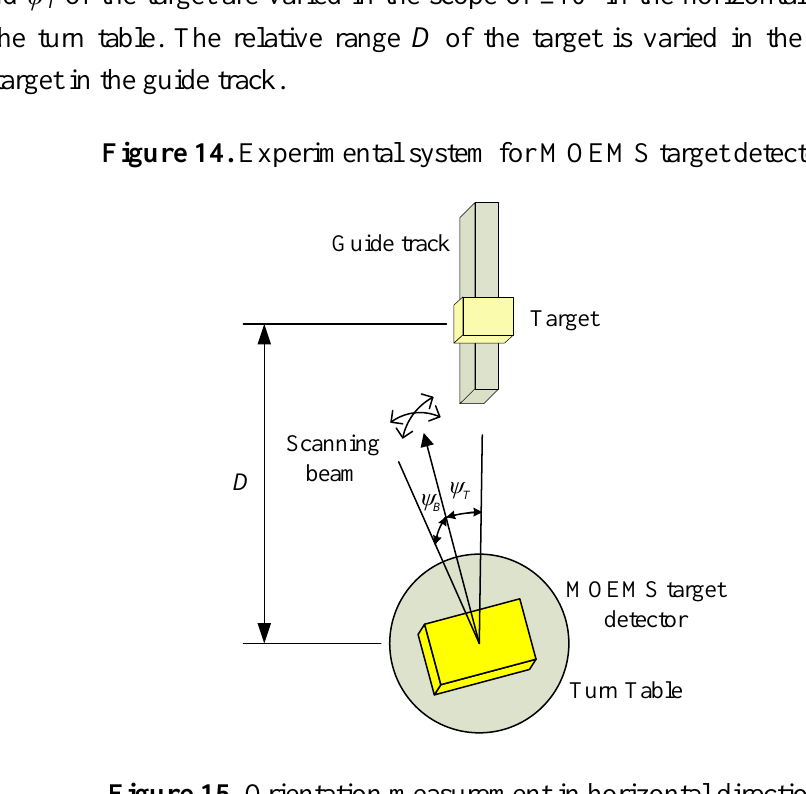
Figure 15. Orientation measurement in horizontal